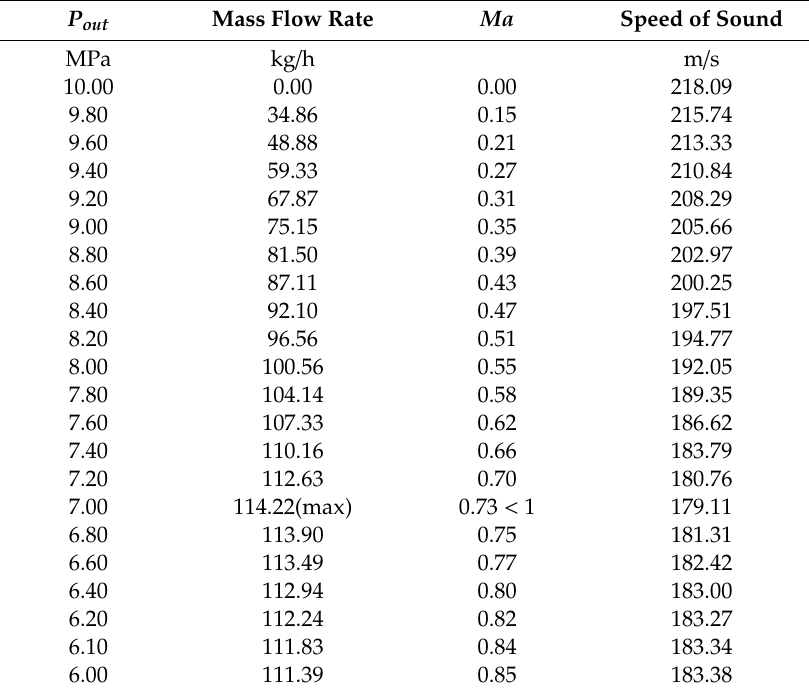
Table 6. The sealing performance of round hole calculated by 1-D